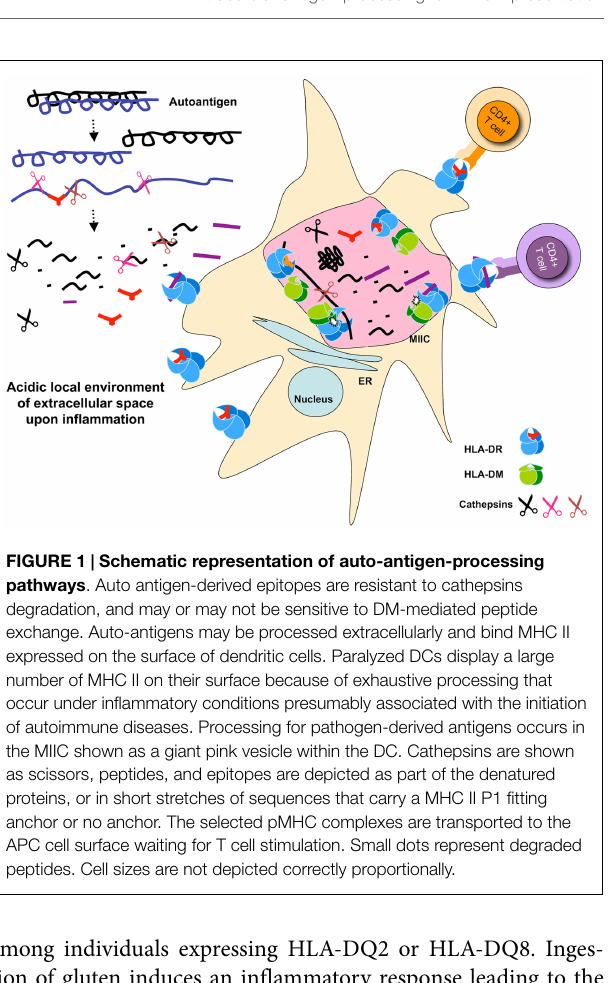
among individuals expressing HLA-DQ2 or HLA-DQ8.